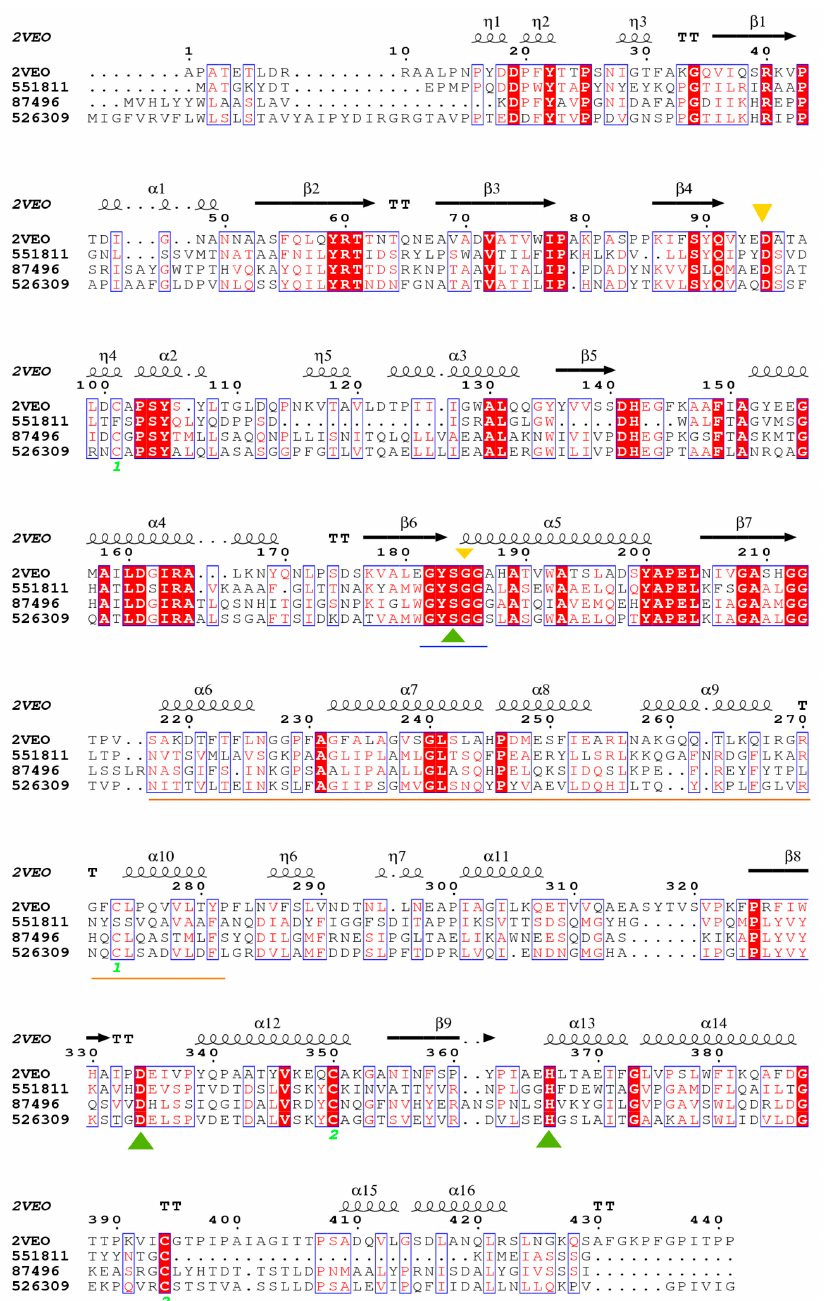
Figure 4. Structural-based multi-alignment of T. harzianum 526309, 551811 and 87496 with 2VEO lipase from C. antarctica (CALA). Blue line highlights the pentapeptide; orange line, the lid domain; green triangles, the catalytic triad; and yellow triangles, the oxyanion. Alpha helices and beta sheets are indicated at the top. Identical (bold white letters on red background) and similar amino acids (standard red letters) are shown.